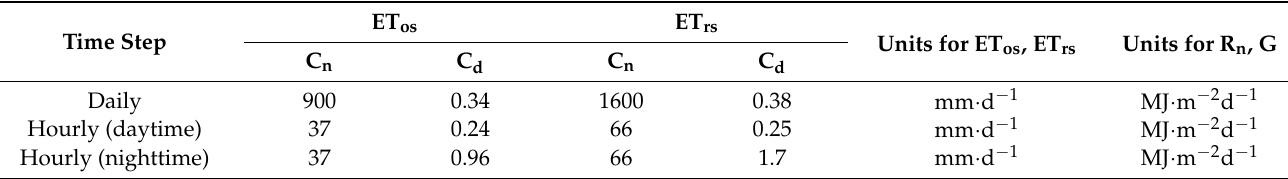
Table 2. Values for Cn and Cd in Equation